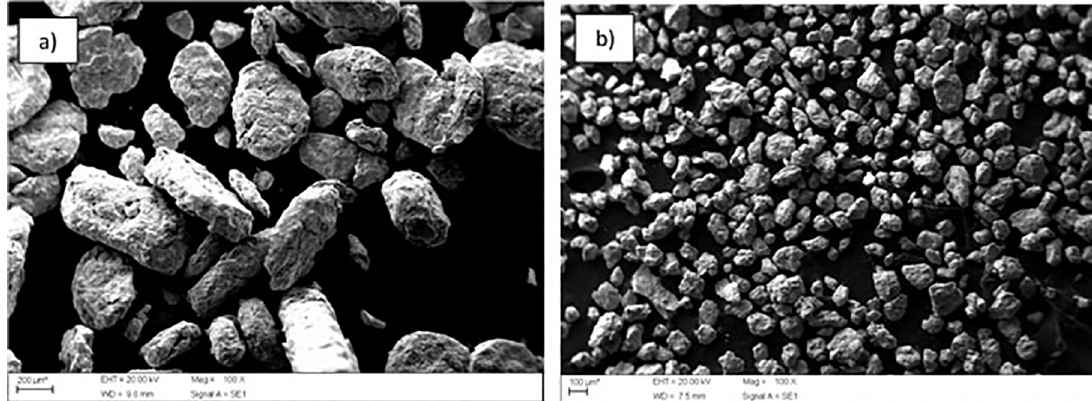
Figure 4. Particles of the duplex stainless steel duplex with addition of 3% NbC after (a) 5 h and (b) 20 h of